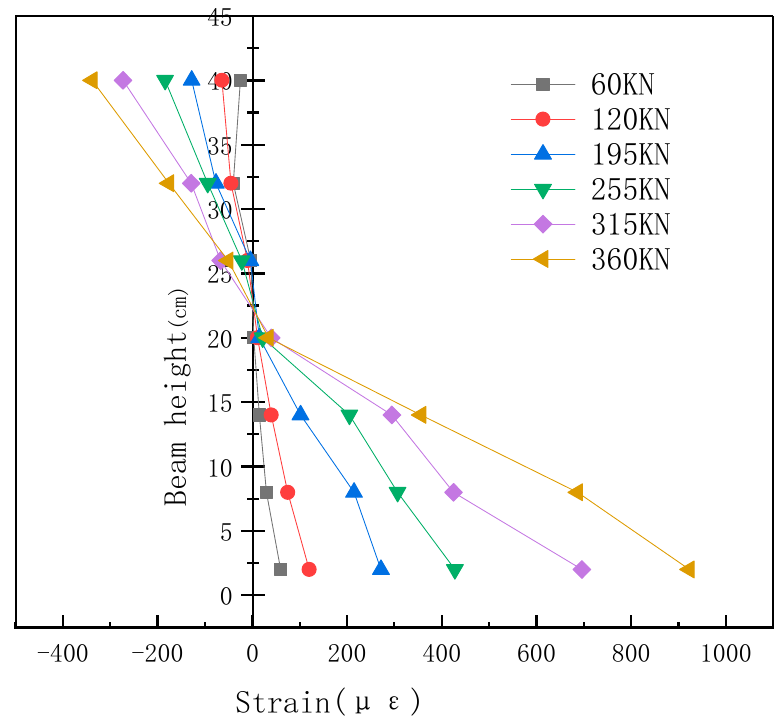
Figure 18. Strain of test beam L3 along beam height.